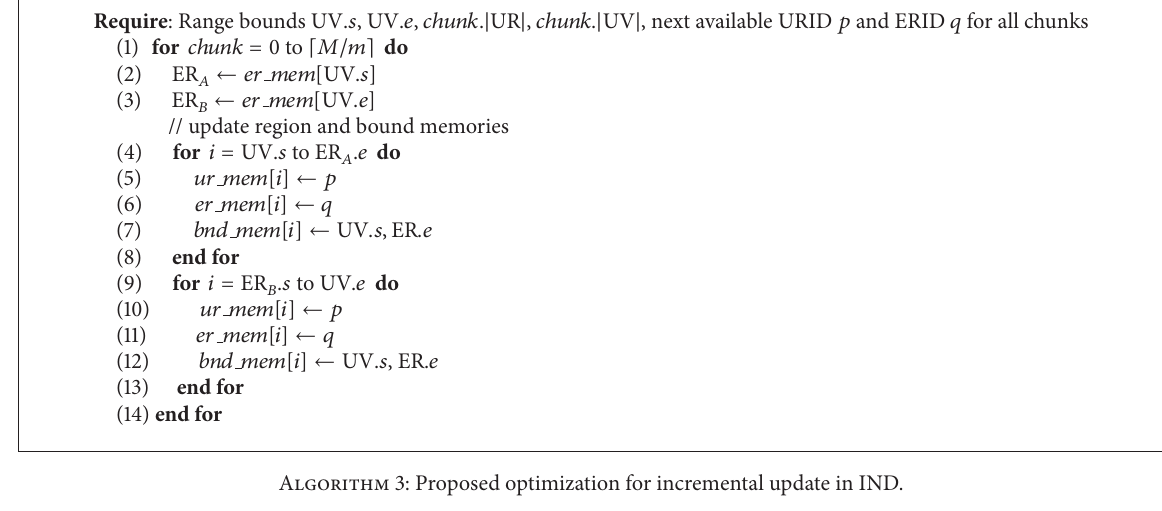
keys UV .𝑠 = 6 and UV .𝑒 = 10 to get URIDs. With